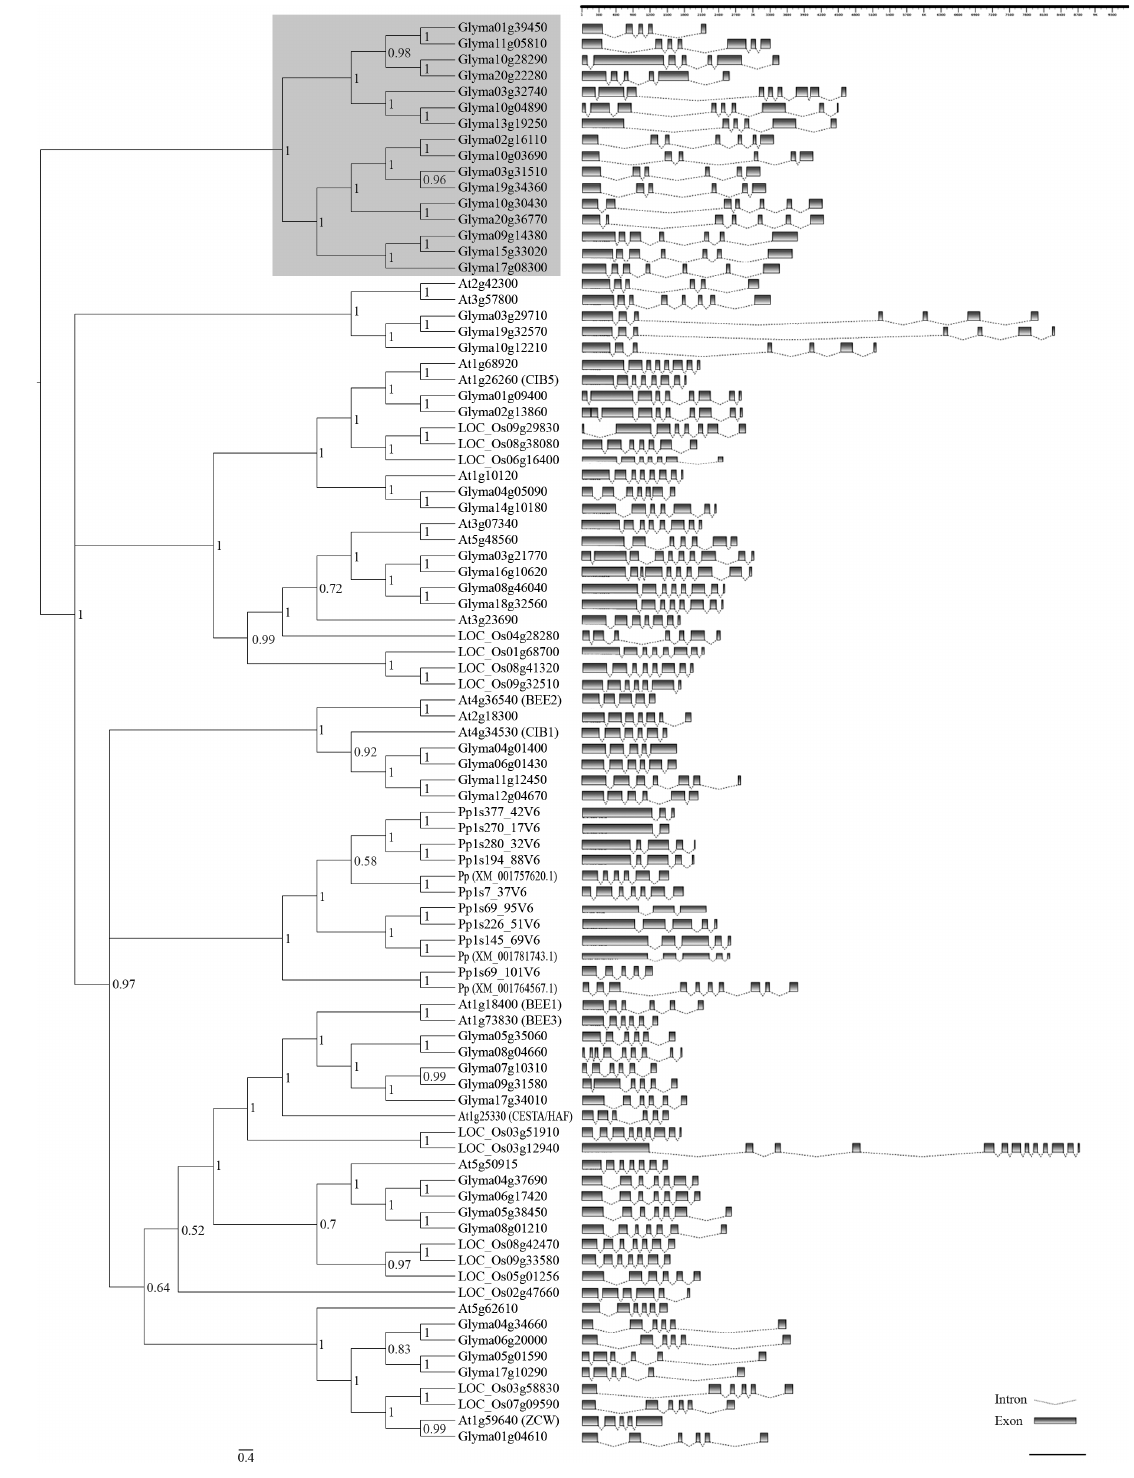
Figure 2 - Phylogenetic relationships among bHLH subgroup 25 members. The phylogenetic tree shown on the left comprises 89 plant bHLH protein se- quences.TheBayesiananalysiswasconductedusingMr.Bayesv3.1.2,afteralignmentoffull-lengthbHLHproteinsfromselectedplantspeciesbymeans ofClustalW.TheunrootedcladogramwaseditedusingFigTreev1.3.1software.Nodalsupportisgivenbyposterioriprobabilityvaluesshownnexttothe corresponding nodes. The scale bar indicates the estimated number of amino acid substitutions per site. The gray area denotes a specific soybean cluster. Previously reported bHLH genes were identified according to their accession/locus numbers, the other genes were designated according to their locus ID in Phytozome. A. thaliana (At); G. max (Glyma); O. sativa (LOC_Os) and P. patens (Pp). The graph on the right shows gene organization of full-length coding sequences from 89 plant bHLHs. Intron-exon maps were drawn using Fancy Gene v1.4 software, according to sequence data available in